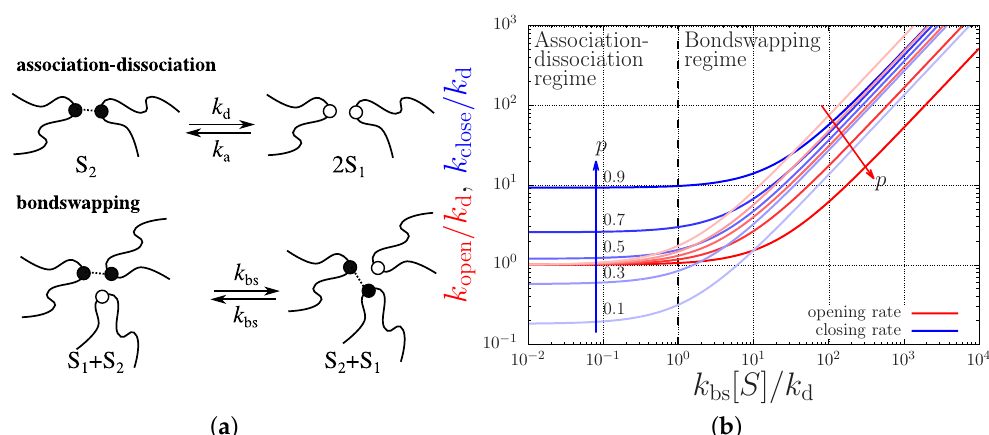
Figure 5. ( a ) Cartoons of the association-dissociation and bondswapping mechanisms. ( b ) Opening and closing rates, k open and k close , of a sticker against the bondswapping rate k bs . The units are rendered dimensionless using the sticker dissociation rate, k d , and the overall sticker concentration, [ S ] . The curves are calculated for a various fraction of closed stickers, p